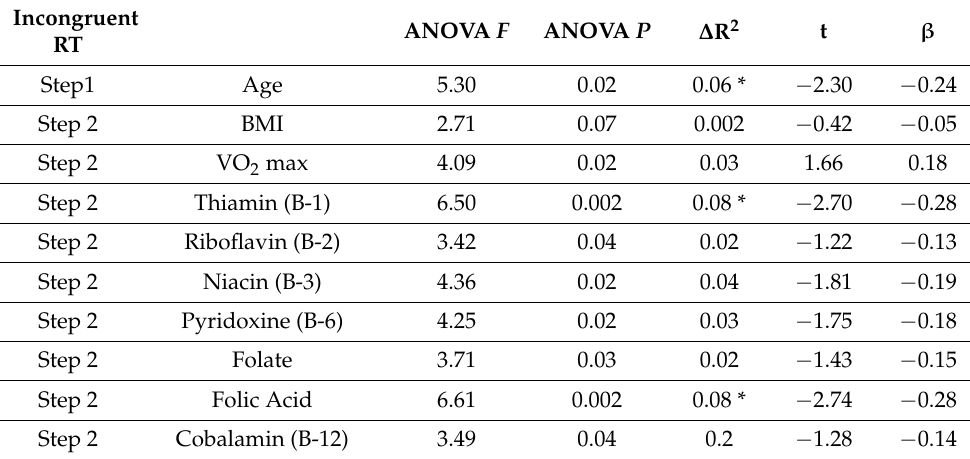
Table 6. Incongruent Reaction Time Regressions.